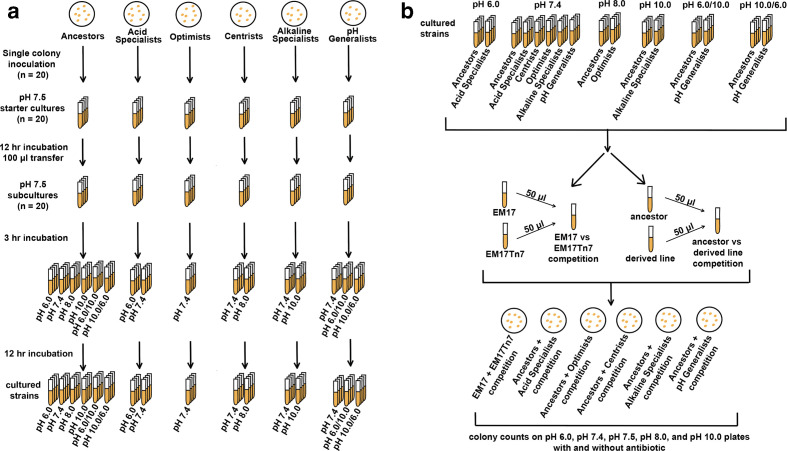
2a. This illustration outlines how the 
V. fischeri
 ancestors and derived lines were grown and at what pH values acclimation took place. The pH generalists involved two different acclimation schemes (pH 6.0/10.0=pH 6.0→10.0→6.0 and pH 10.0/6.0=pH 10.0→6.0→10.0). 2b. After acclimation, the ancestors and derived lines were competed against one another at select pH values. The two ancestral varieties were also competed against one another as controls, including with the pH 6.0→10.0→6.0 and pH 10.0→6.0→10.0 schemes.